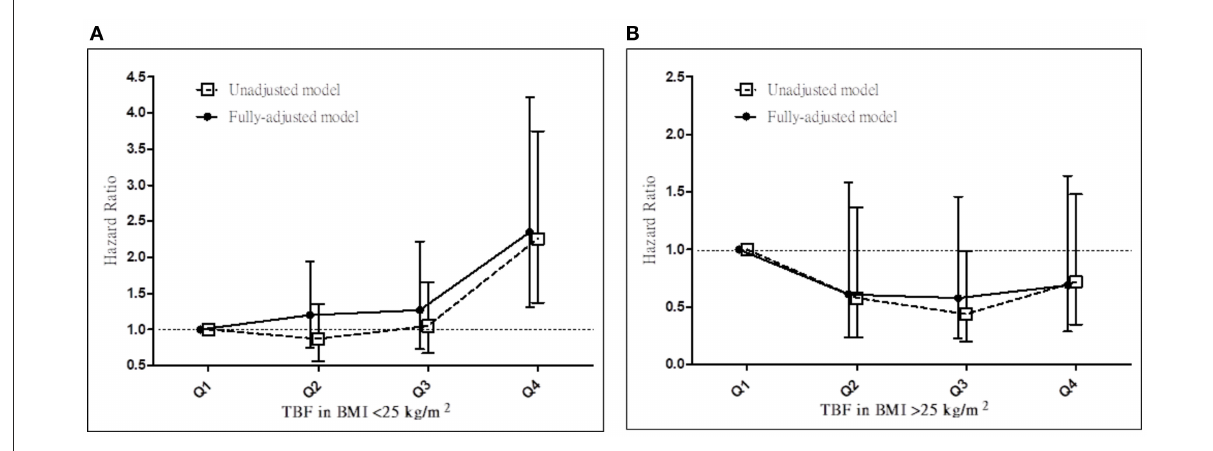
FIGURE2 Hazard ratios for all-cause mortality based on total body fat percentage in patients with a BMI of (A) < 25 and (B) ≥ 25 kg/m 2 before and after adjustments. TBF%, total body fat percentage; BMI, body mass index.